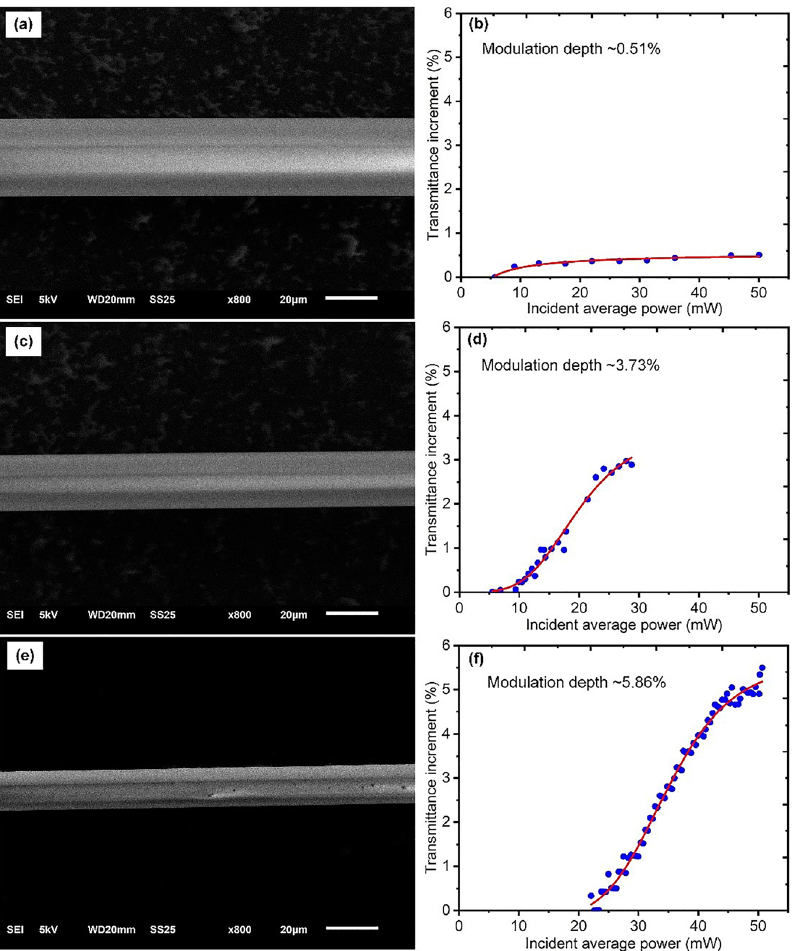
three differently drawn TFs that are used in the following